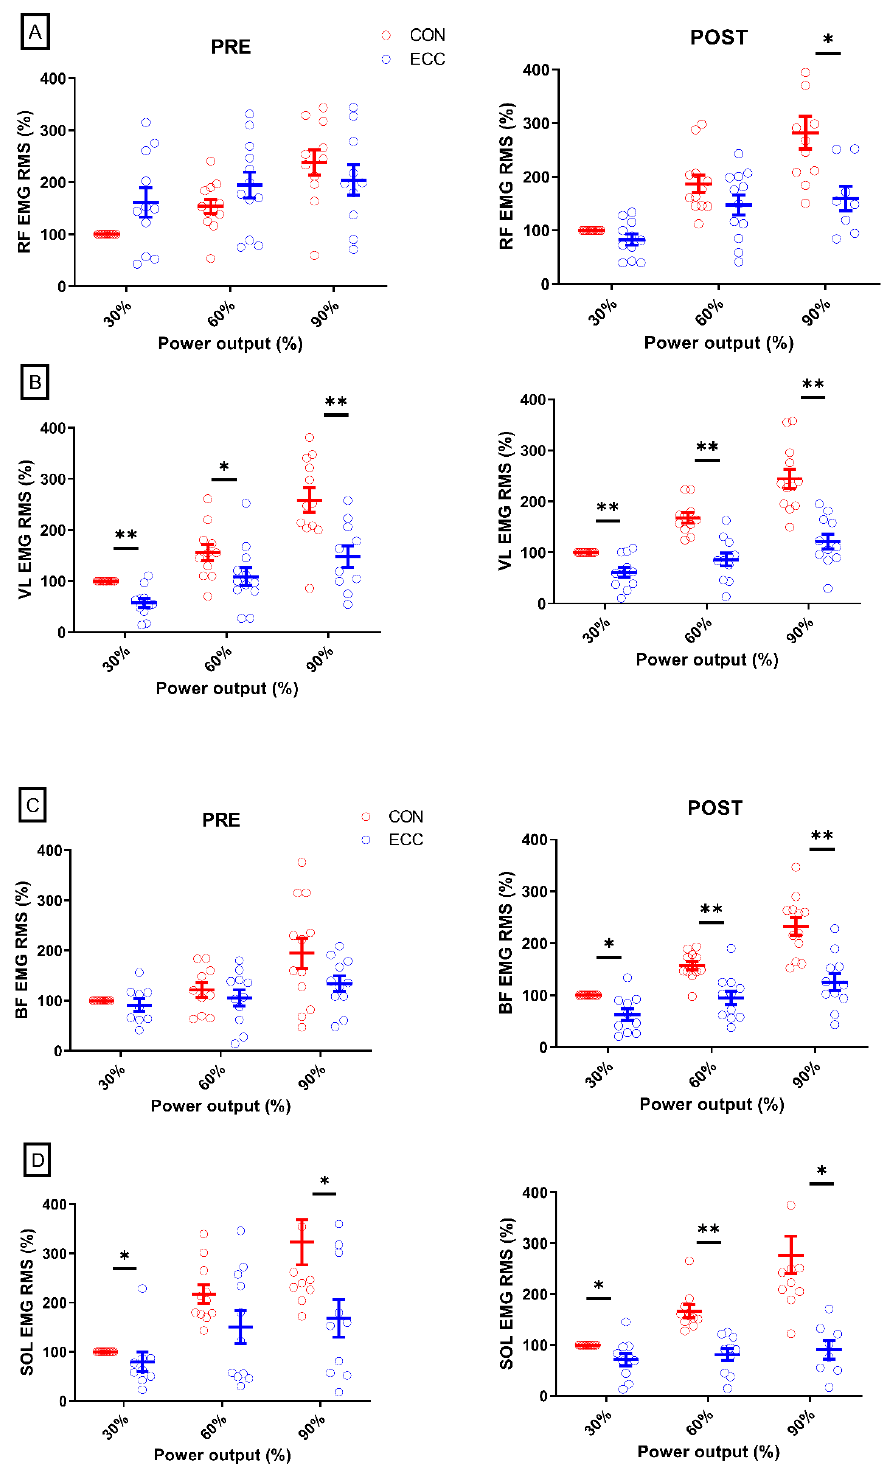
Figure 3. Muscle activity. Panel A displays the scattered muscle activity (EMG RMS) of the rectus femoris (RF) muscle before (PRE) and after (POST) the four sessions of cycling. Panels B – D show the EMG RMS of the vastus lateralis (VL), biceps femoris (BF), and soleus (SOL) muscles, respectively. Data were normalized to the EMG RMS in CON cycling at 30% of the peak power output the same day. Only three exercise intensities are displayed for sake of clarity. Di ff erence between CON and ECC cycling value at a given power output: * means p < 0.05; ** means p < 0.01. Error bars represent the standard